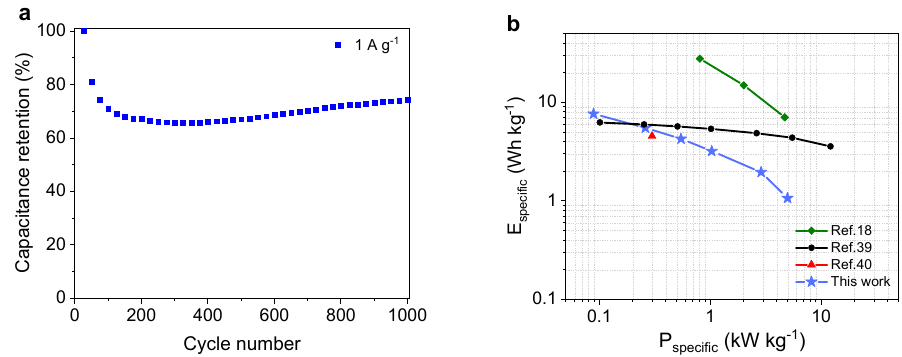
Figure 9. Cycling stability at a current density of 1 A g − 1 ( a ) and the Ragone plot of the specific energy–power density relationship of the hybrid capacitor and other various hybrid devices ( b ).